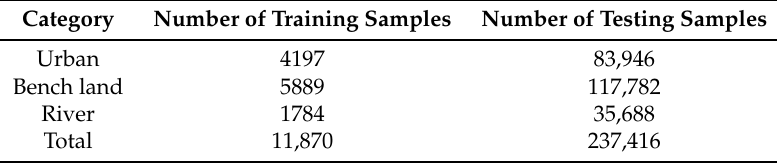
Figure 4. The OA of different ratios of training data by different methods on three real PolSAR images: ( a ) Xi’an area; ( b ) Flevoland; and ( c ) San Francisco Bay. Table 2. Number of samples for Xi’an